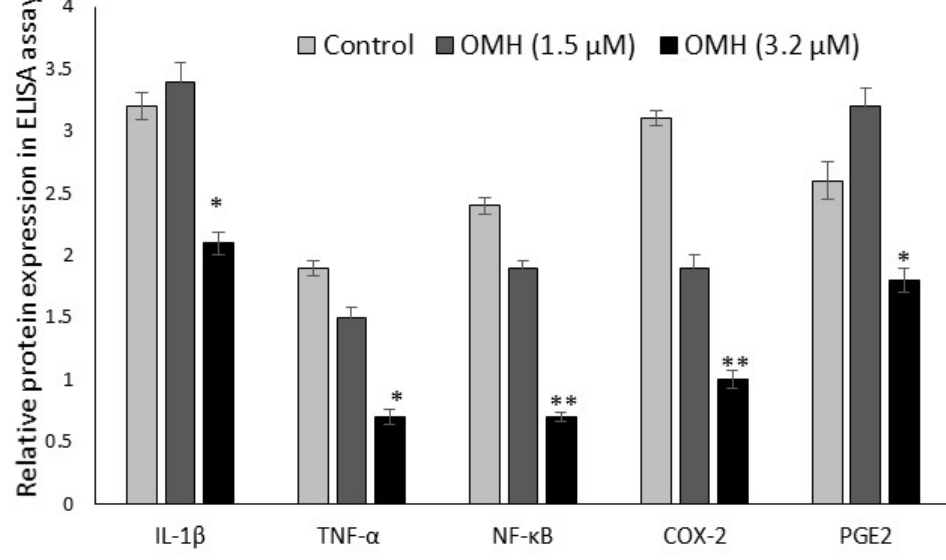
Figure 5. Effect of OMH on protein expression levels of IL-1 β , TNF- α , NF- κ B, COX-2, and PGE-2 in HT-115 cells after 48 h. Data presented as the means ± SD (n = 6). Values sharing a common superscript as * p ≤ 0.01 and ** p ≤ 0.05 compared with untreated HT-115 cells.